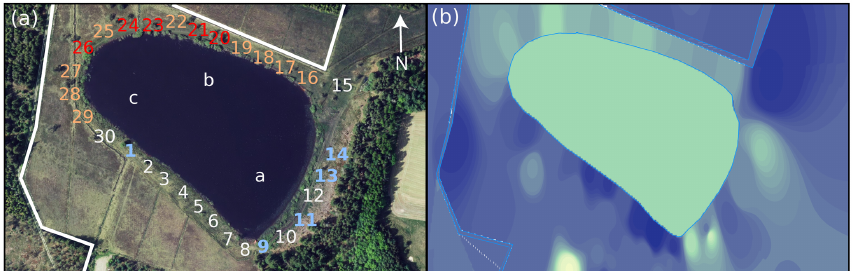
Figure 1. (a) Aerial photo of Lake Tvorup Hul showing groundwater well sampling sites (numbers). Orange numbers denote groundwater recharge sites, red numbers show sites with a high degree of recharge, white numbers represent possible groundwater discharge sites and light blue shows model-isolated discharge sites. Positions a, b and c show the three sampling sites in the lake. Missing samples in the northeastern part are due to an absence of groundwater in the area. The adjacent drainage channels north and west of the lake are marked with white lines. (b) Inverse-distance-weighted (IDW) contour map of fluorescence component C4. The blue-green colour corresponds to lake concentrations; darker blue indicates increased concentrations and lighter blue denotes decreased concentrations throughout the catchment. Areas with low differences between fluorescence in the lake and in the catchment are seen north of the lake and indicate parts with a fast groundwater